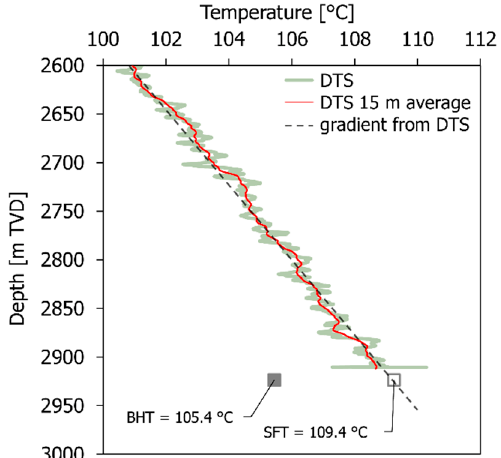
Figure 7. Fiber-optic temperature log in SLS TH4 with BHT data at 2950 m with shut-in time of 86,400 s. The bold red line is a DTS profile measured after the well has been shut for 16 months with a spatial sampling of 1 m. The thin red line is the same DTS profile averaged over 30 m. The dashed line is the assumed reservoir gradient, derived from DTS.